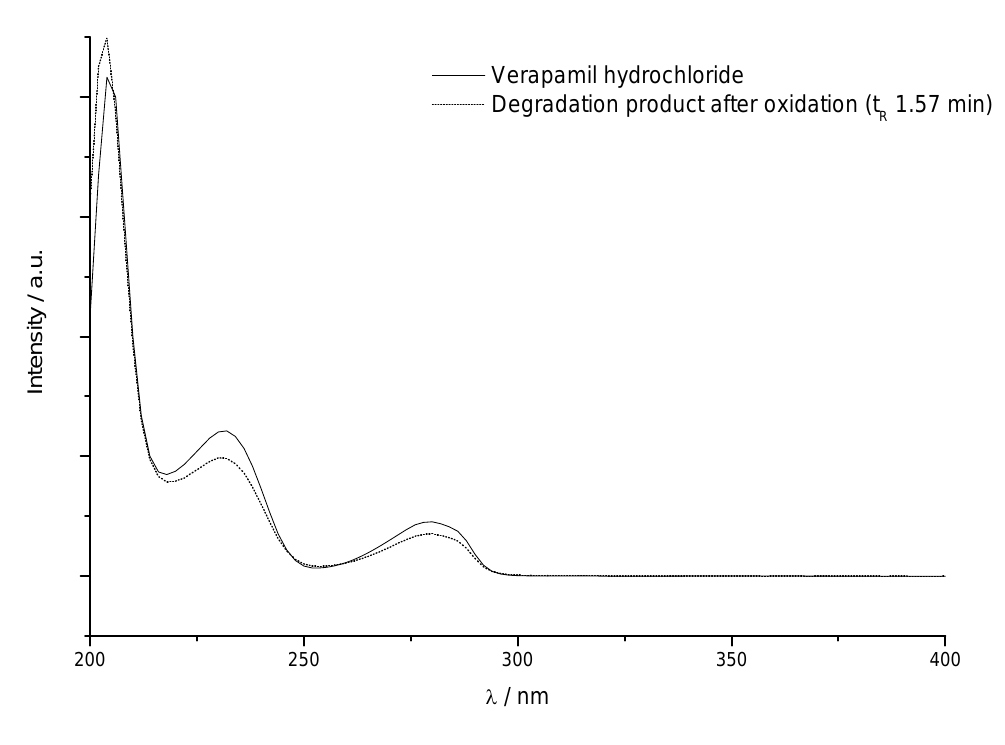
Figure 4. Overlay of UV spectra of verapamil hydrochloride (t and after stress conditions (---) obtained for degraded solutions under oxidation (t k’